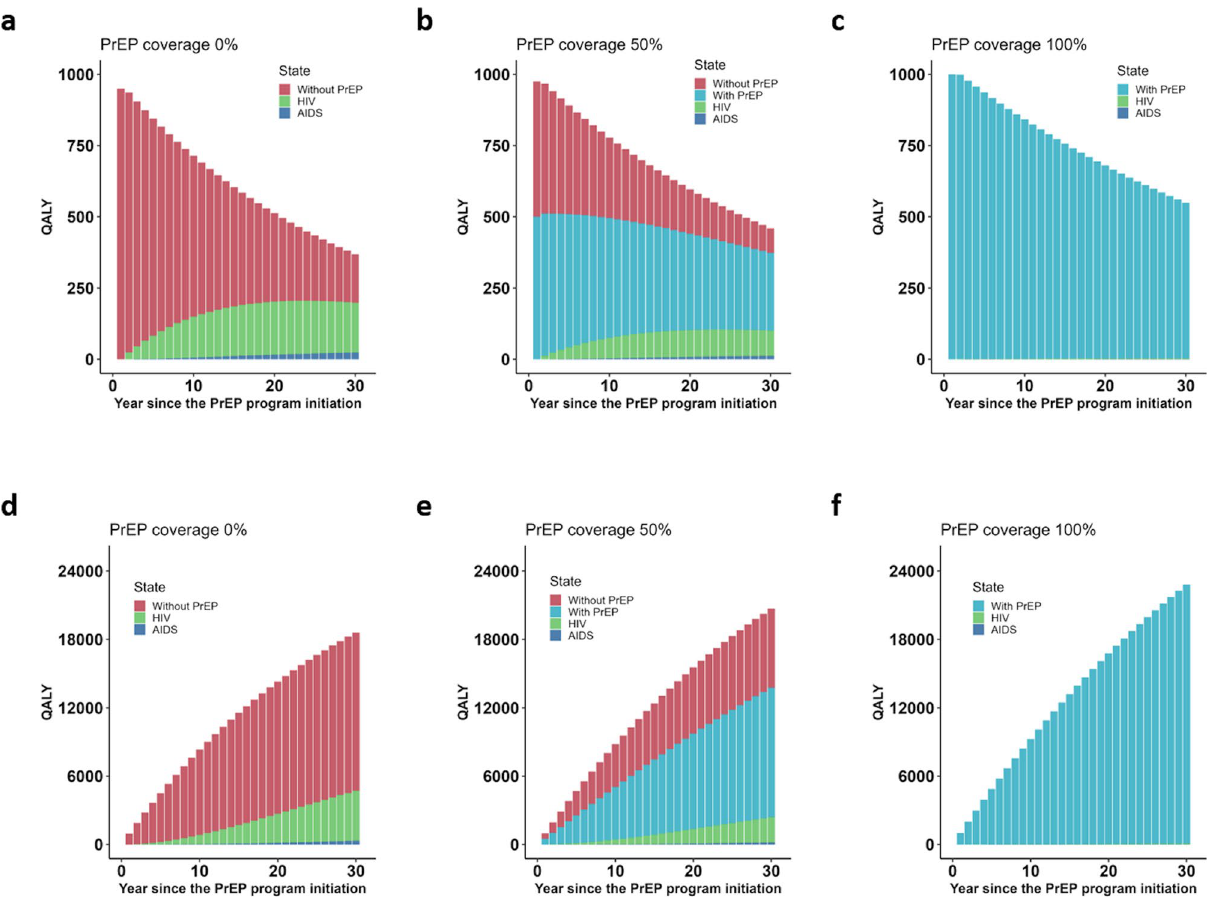
Figure 3. Yearly QALY distribution over 30 years. Yearly QALYs related to treatment and pre-exposure prophylaxis (PrEP) calculated, assuming an annual discount rate of 2%. ( a ) Yearly QALYs if PrEP is not introduced. ( b ) Yearly QALYs with the introduction of PrEP to 50% of the cohort. ( c ) Yearly QALYs with the introduction of PrEP to the whole cohort. ( d ) Cumulative QALYs if PrEP is not introduced. ( e ) Cumulative QALYs with the introduction of PrEP to 50% of the cohort. ( f ) Cumulative QALYs with the introduction of PrEP to the whole